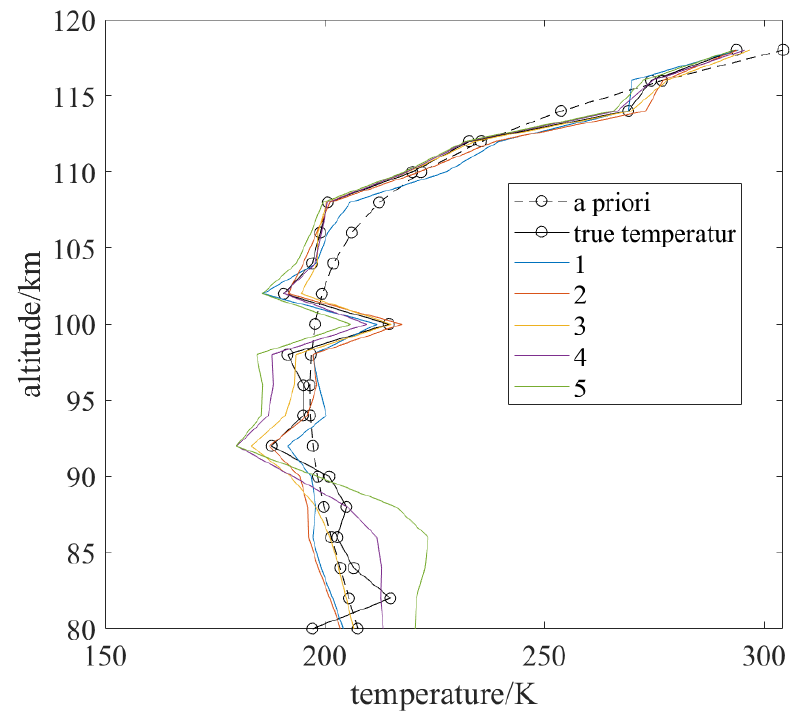
Figure 10. Retrieval of atmospheric temperature in MLT region (1–5 represents the number of iteration steps).